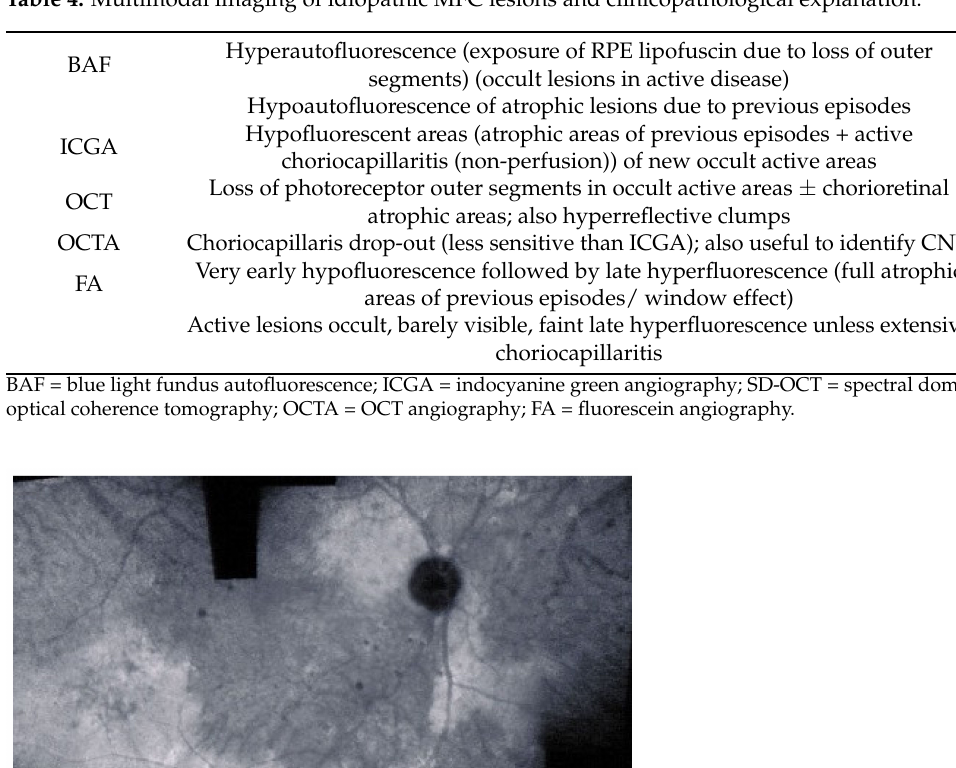
Table 4. Multimodal imaging of idiopathic MFC lesions and clinicopathological explanation.